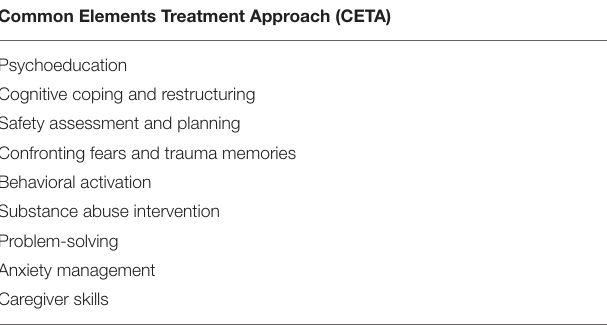
TABLE 1 | Key elements of the Common Elements Treatment Approach